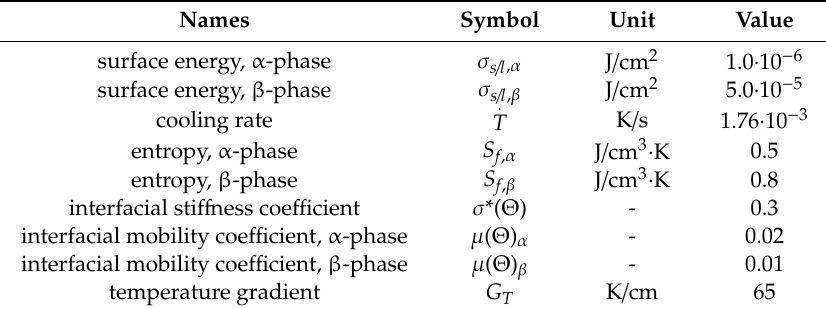
Table 1. Numerical and physical parameter